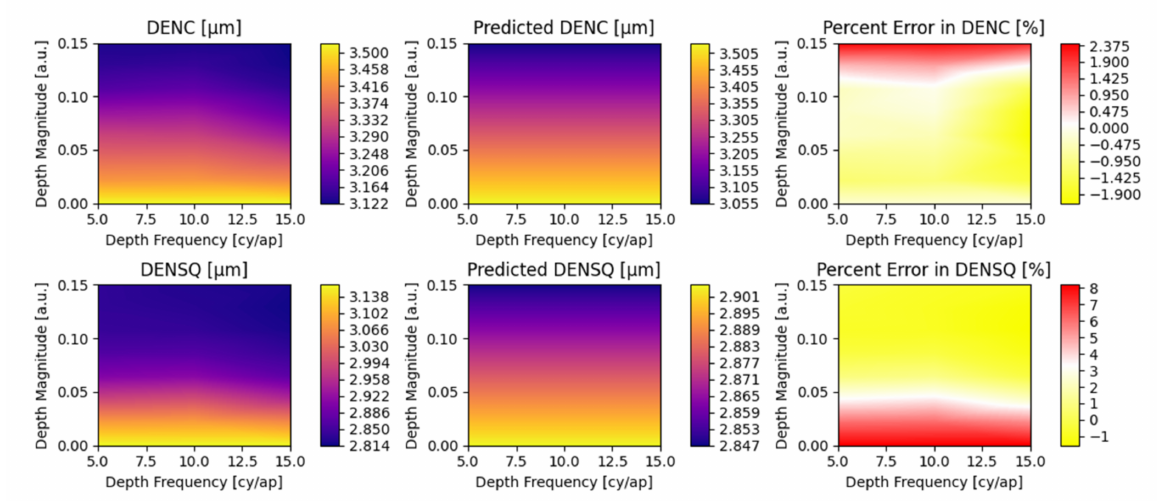
Figure A14. Depth Frequency vs. depth magnitude. ( κ = ω = δ = 0, ξ = 10, σ = 0.05, θ = 15 ◦ ).